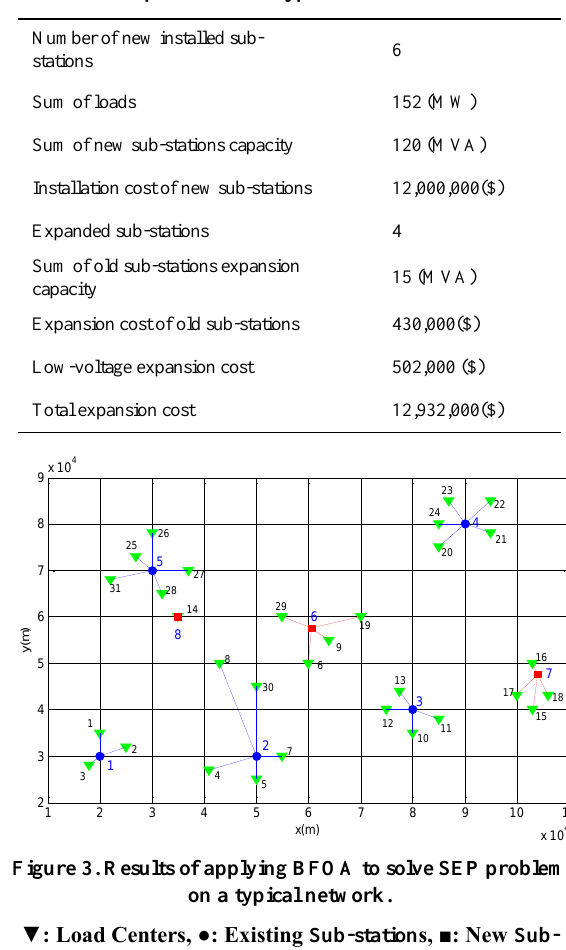
Table 2. Detailed results of applying PSO to solve SEP problem on a typical network.